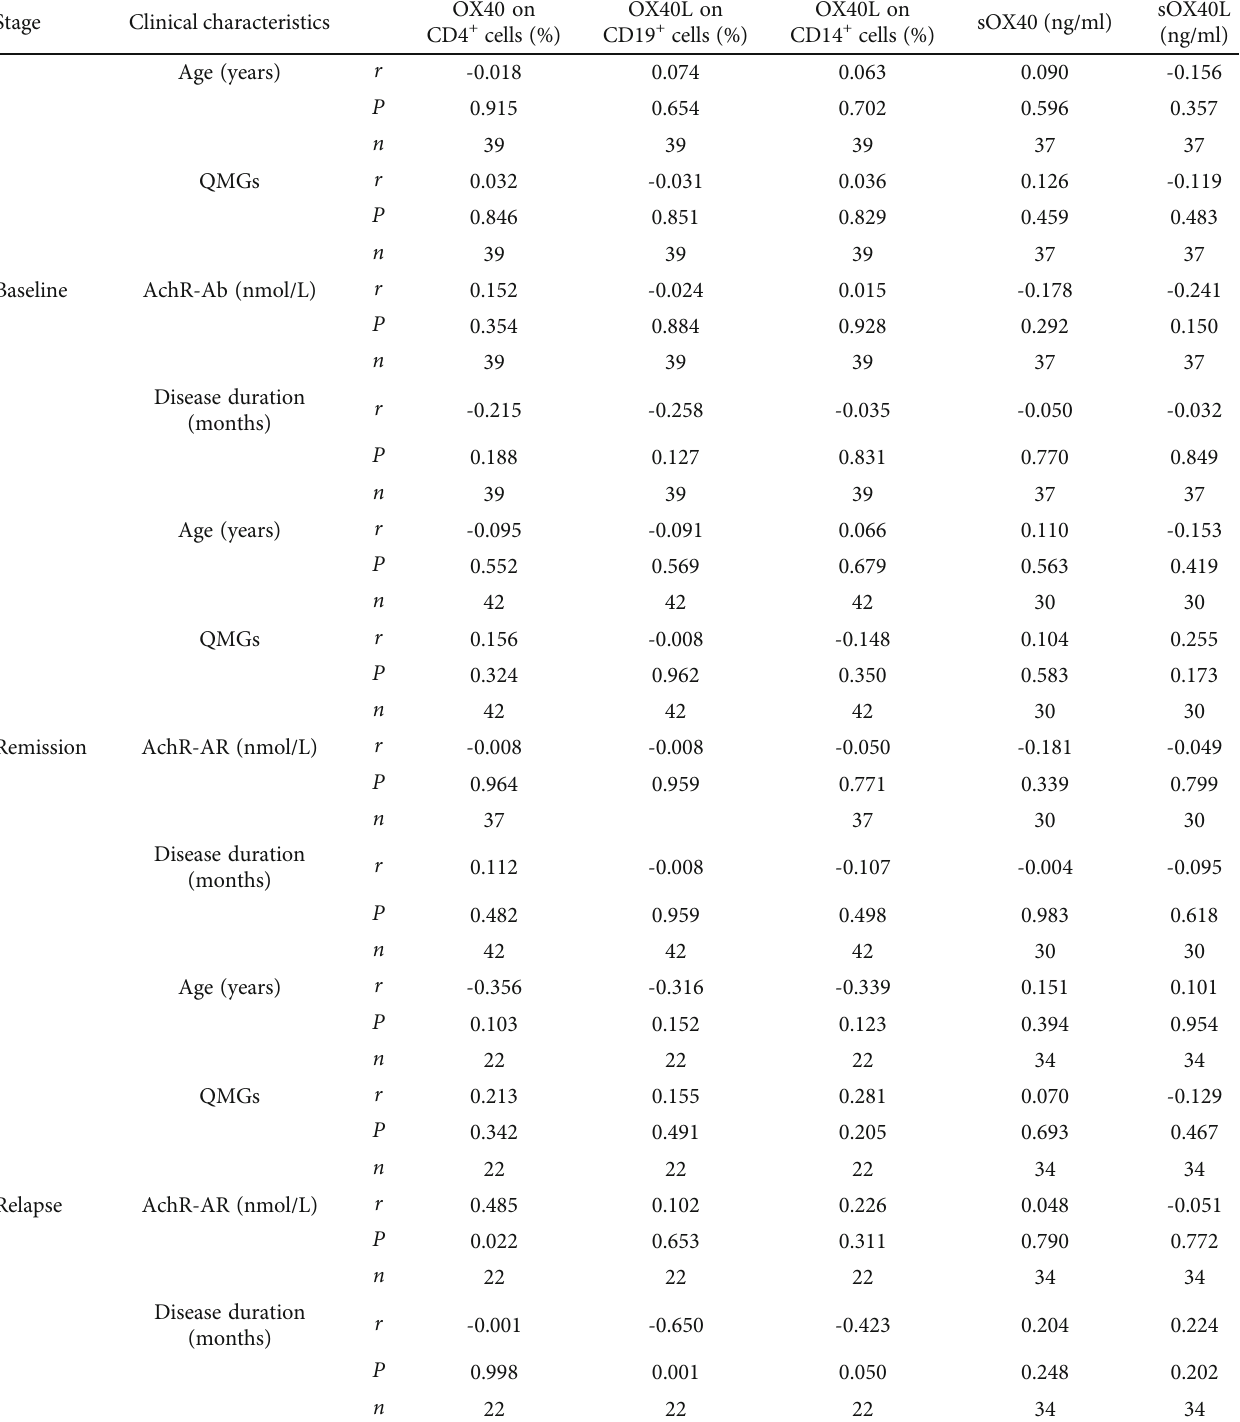
Table 5: Correlation between clinical data and laboratory